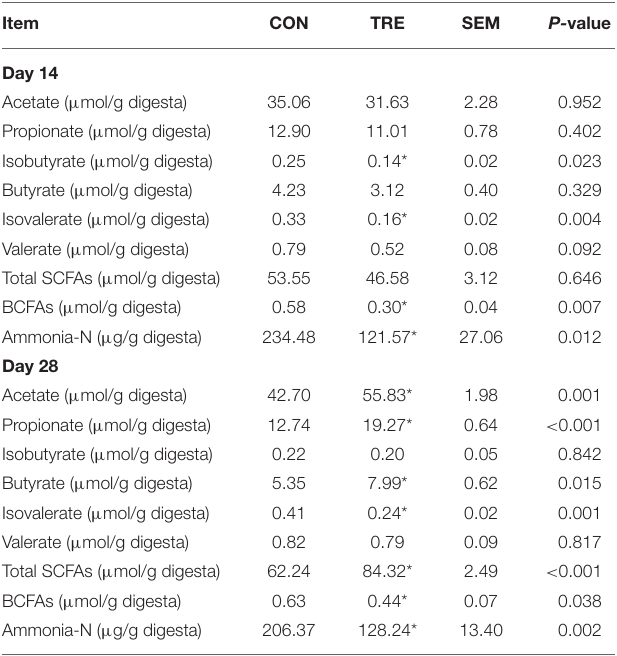
TABLE 2 | Effect of protein restriction and succedent realimentation on the concentration of SCFAs and ammonia-N in colonic digesta of weaned piglets ( n =